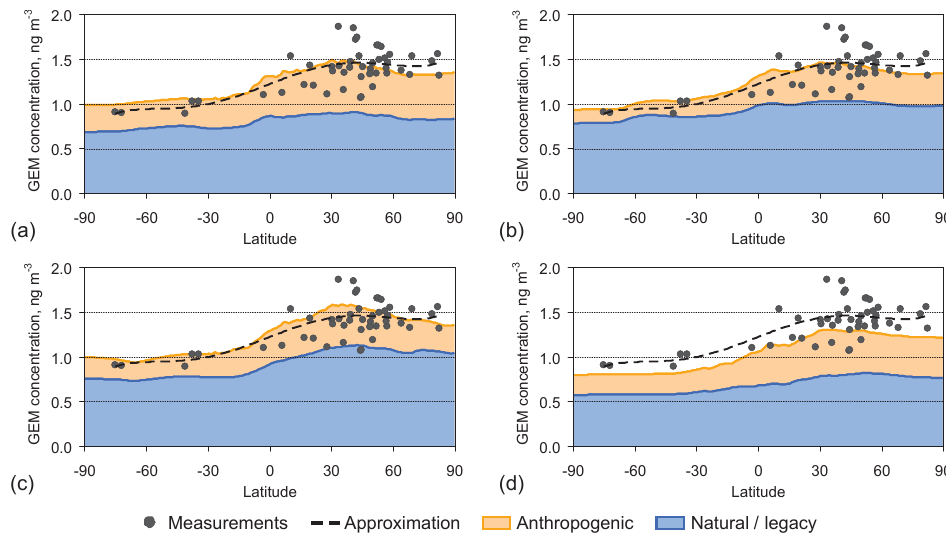
Figure 3. Global zonal-mean distribution of GEM air concentration in 2013 simulated by four models: (a) GLEMOS, (b) GEOS-Chem, (c) GEM-MACH-Hg, and (d) ECHMERIT. Black dots are the same observations as in Fig. 2 and the dotted line is a polynomial approxima-